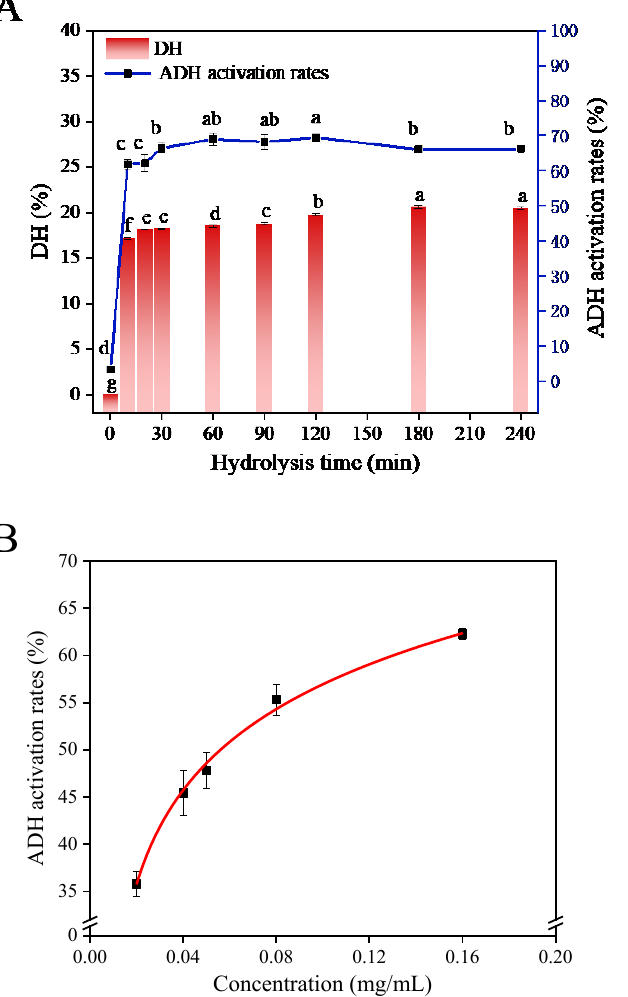
Figure 2. ( A ) ADH activation rates and DH of Alcalase in hydrolysis time. ( B ) EC 50 values for ADH activation by CPHs-Pro-30. (Different letters (a–g) represent significant differences in values.)